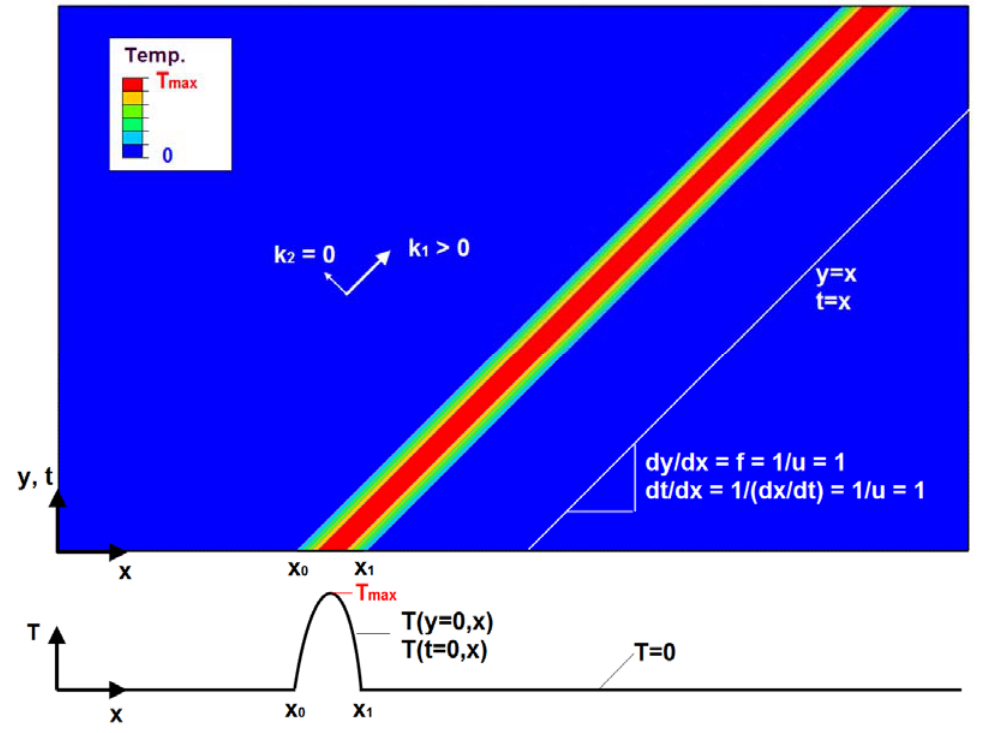
Figure 3. The Fourier heat conduction equation with k 1 /k 2 → ∞ is hyperbolic and has transport character. The diagram is valid for the x-y plane as well as for the x-t plane. As an example, the direction field y´ = f(x,y) = 1 is integrated with the orthotropic heat conduction ( k 2 = 0).